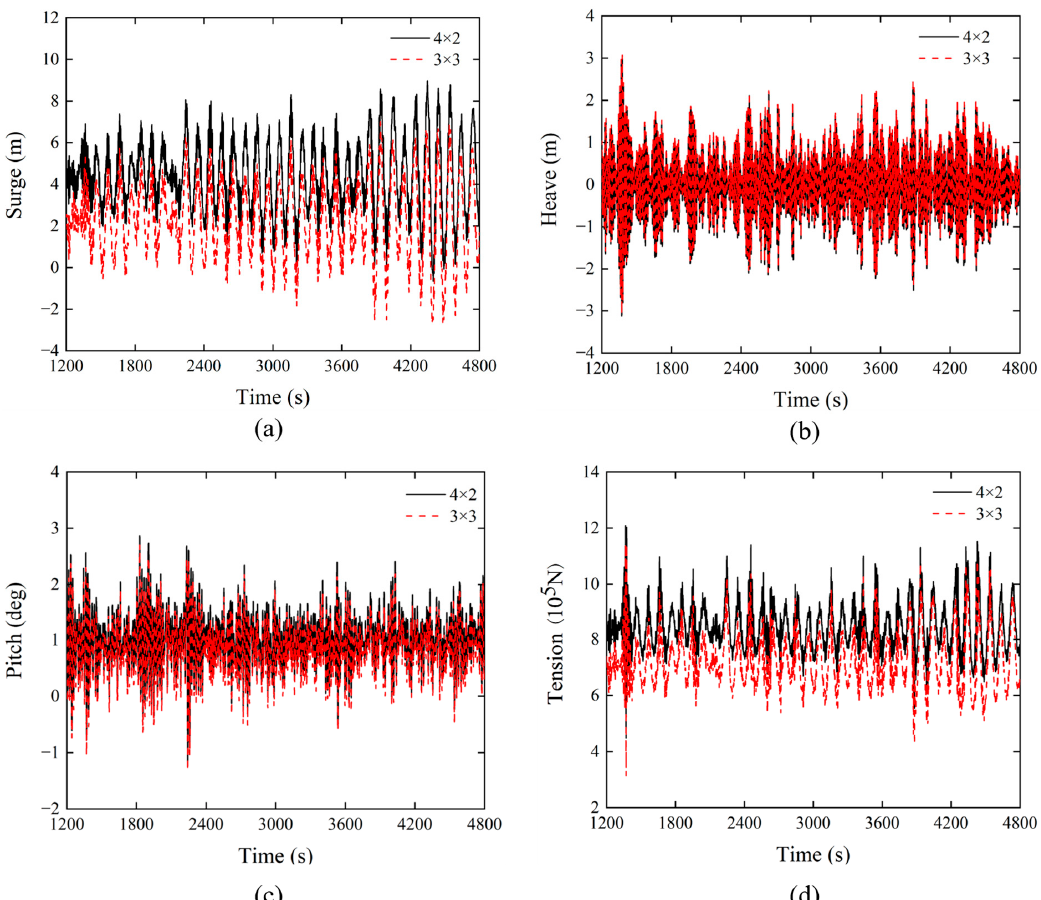
Figure 12. Comparison of ( a ) surge, ( b ) heave, ( c ) pitch, and ( d ) top tension of mooring line T5 in the 4 × 2 system and mooring line T6 in the 3 × 3 system for LC13.